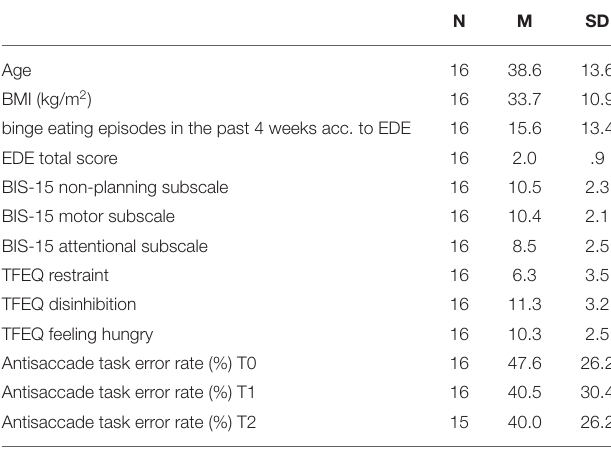
TABLE 1 | Sample characteristics at